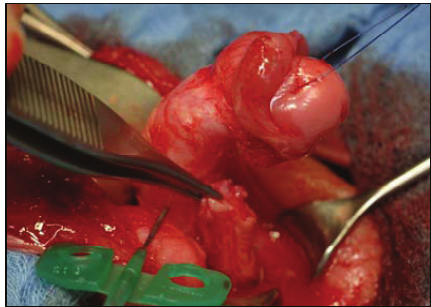
Figure 4: Dorsal perspective of the longitudinal island flap. The graft is right in the centre of the vascular pedicle. The buttonhole is already made.